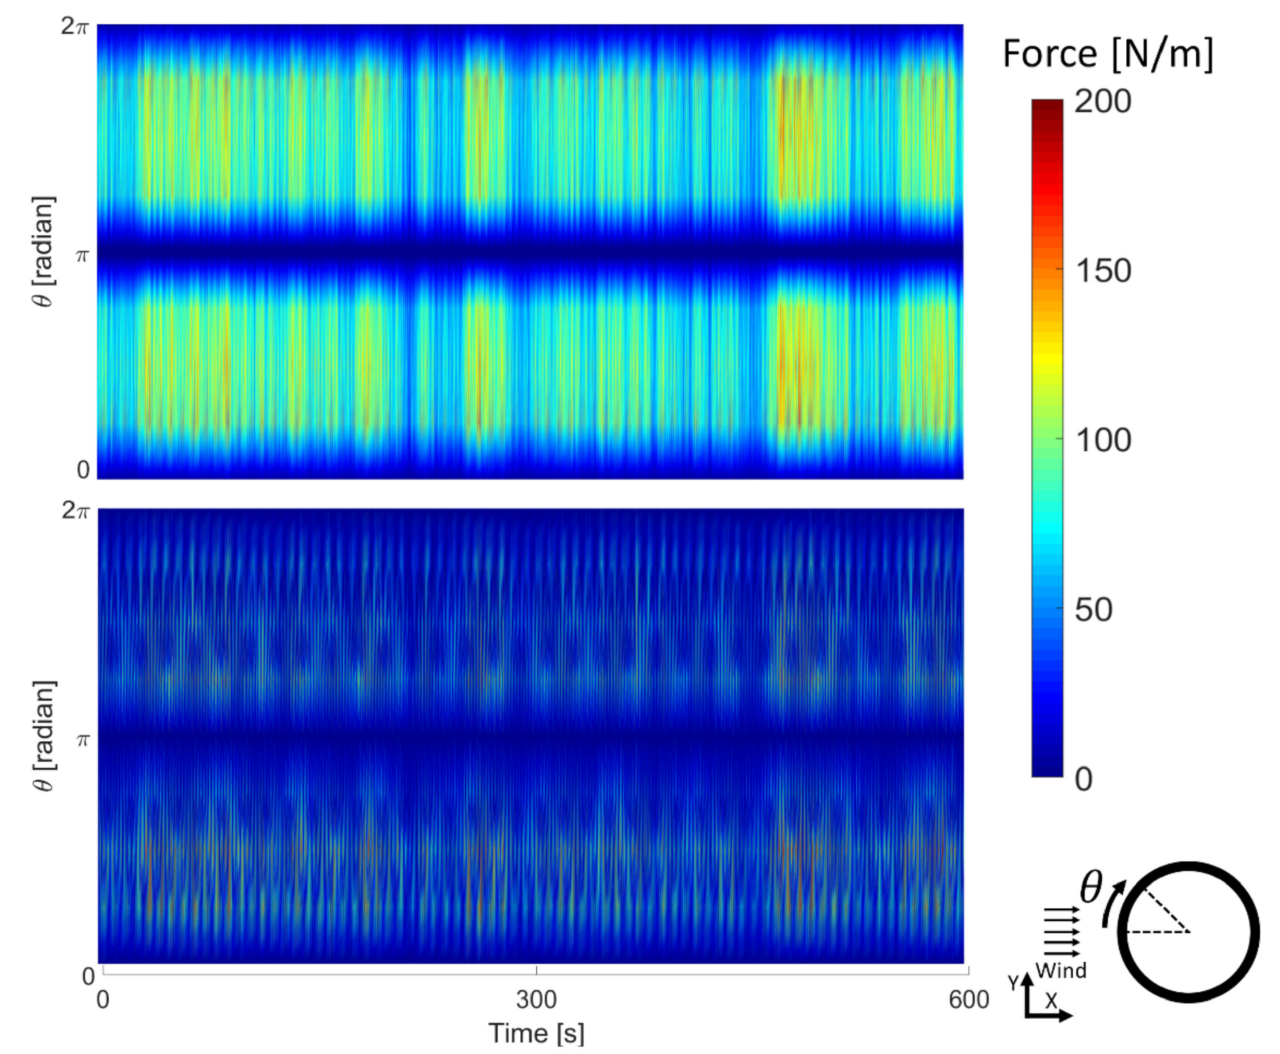
Figure 18. The wind forces per unit of length (Drag, ( top ), and Lift, ( bottom ), in x and y directions respectively) calculated for the Bishop Rock lighthouse helideck as function of location and time over a period of 10 min (600